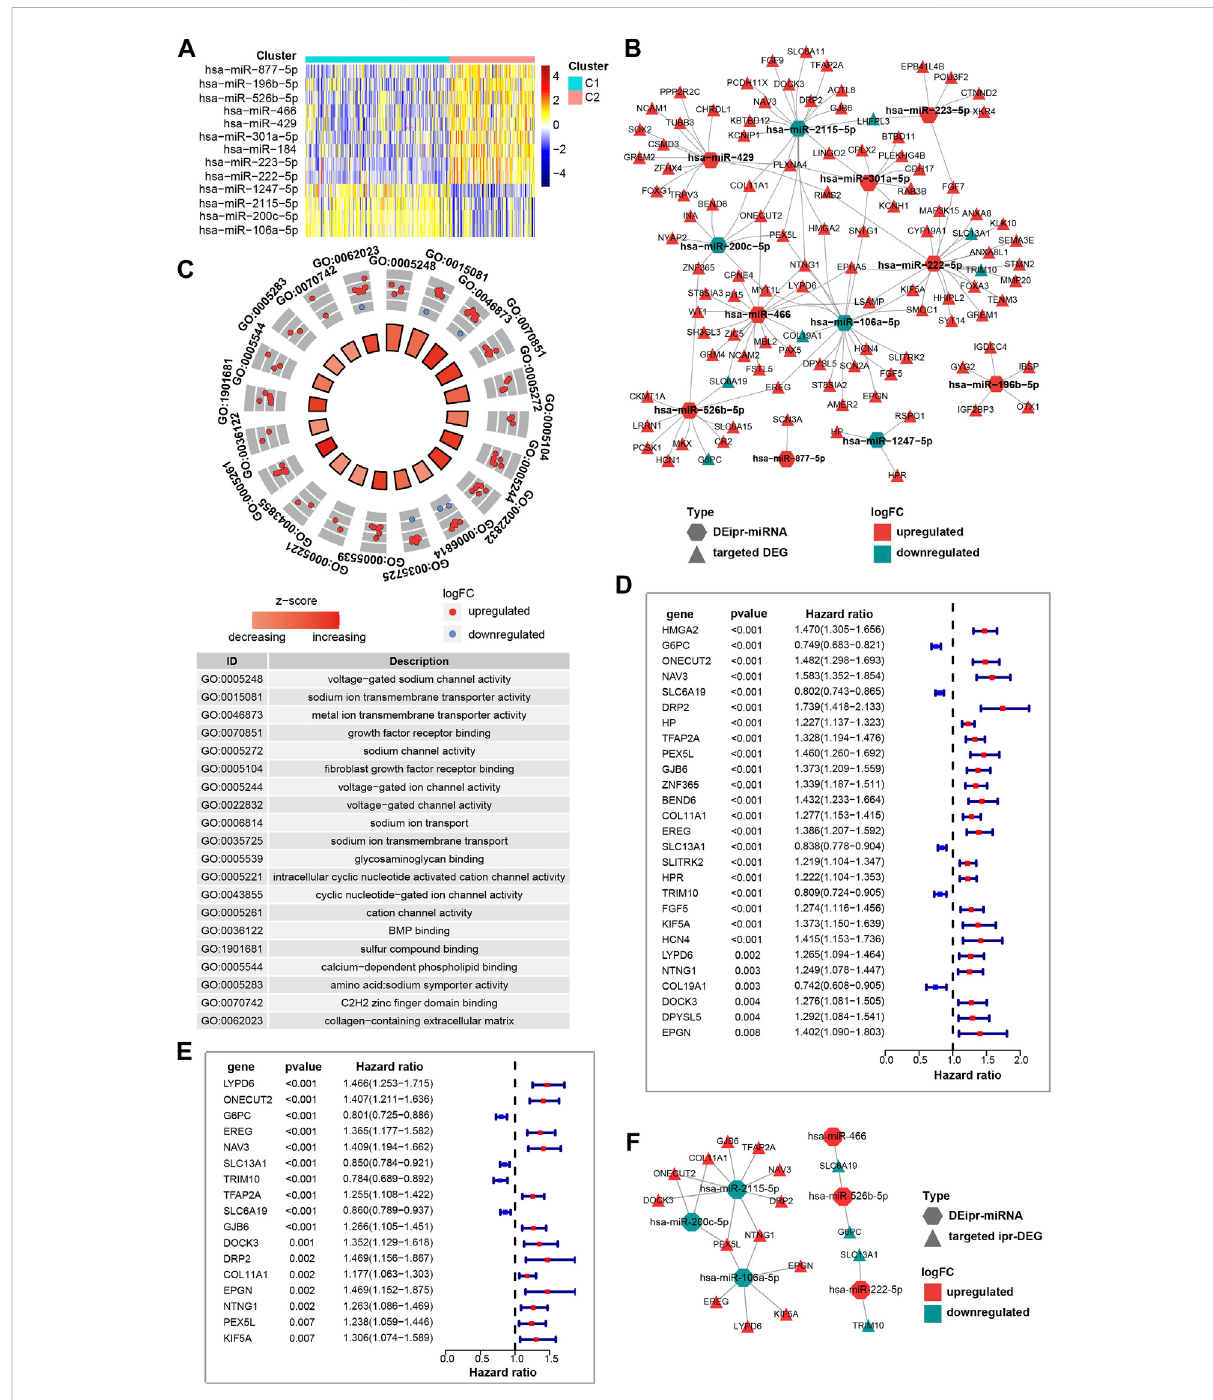
FIGURE 3 Identi fi cation of the prognostic DEipr-miRNAs-regulated DEGs. (A) Heatmap shows the differential expressed ipr-miRNAs (DEipr-miRNAs) betweentheindicatedsubgroupsofccRCC. (B) RegulatorynetworksoftheDEipr-miRNAsandtheirtargetedDEGs. (C) Functionalenrichmentofthe DEipr-miRNAs-targeted DEGs. (D) Univariate cox regression analysis to identify the prognosis-related DEGs (pr-DEGs). (E) Multivariate cox regressionanalysis to identify theindependentprognosis-related DEGs (ipr-DEGs). (F) Regulatory networks of the DEipr-miRNAs and reversely expressed